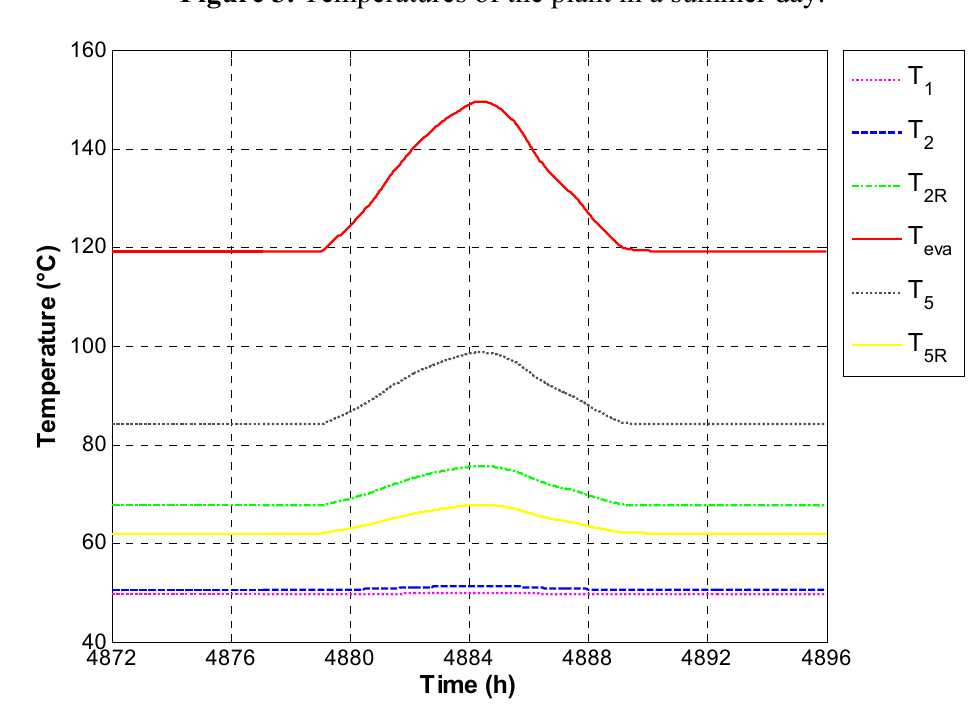
Figure 3. Temperatures of the plant in a summer day.